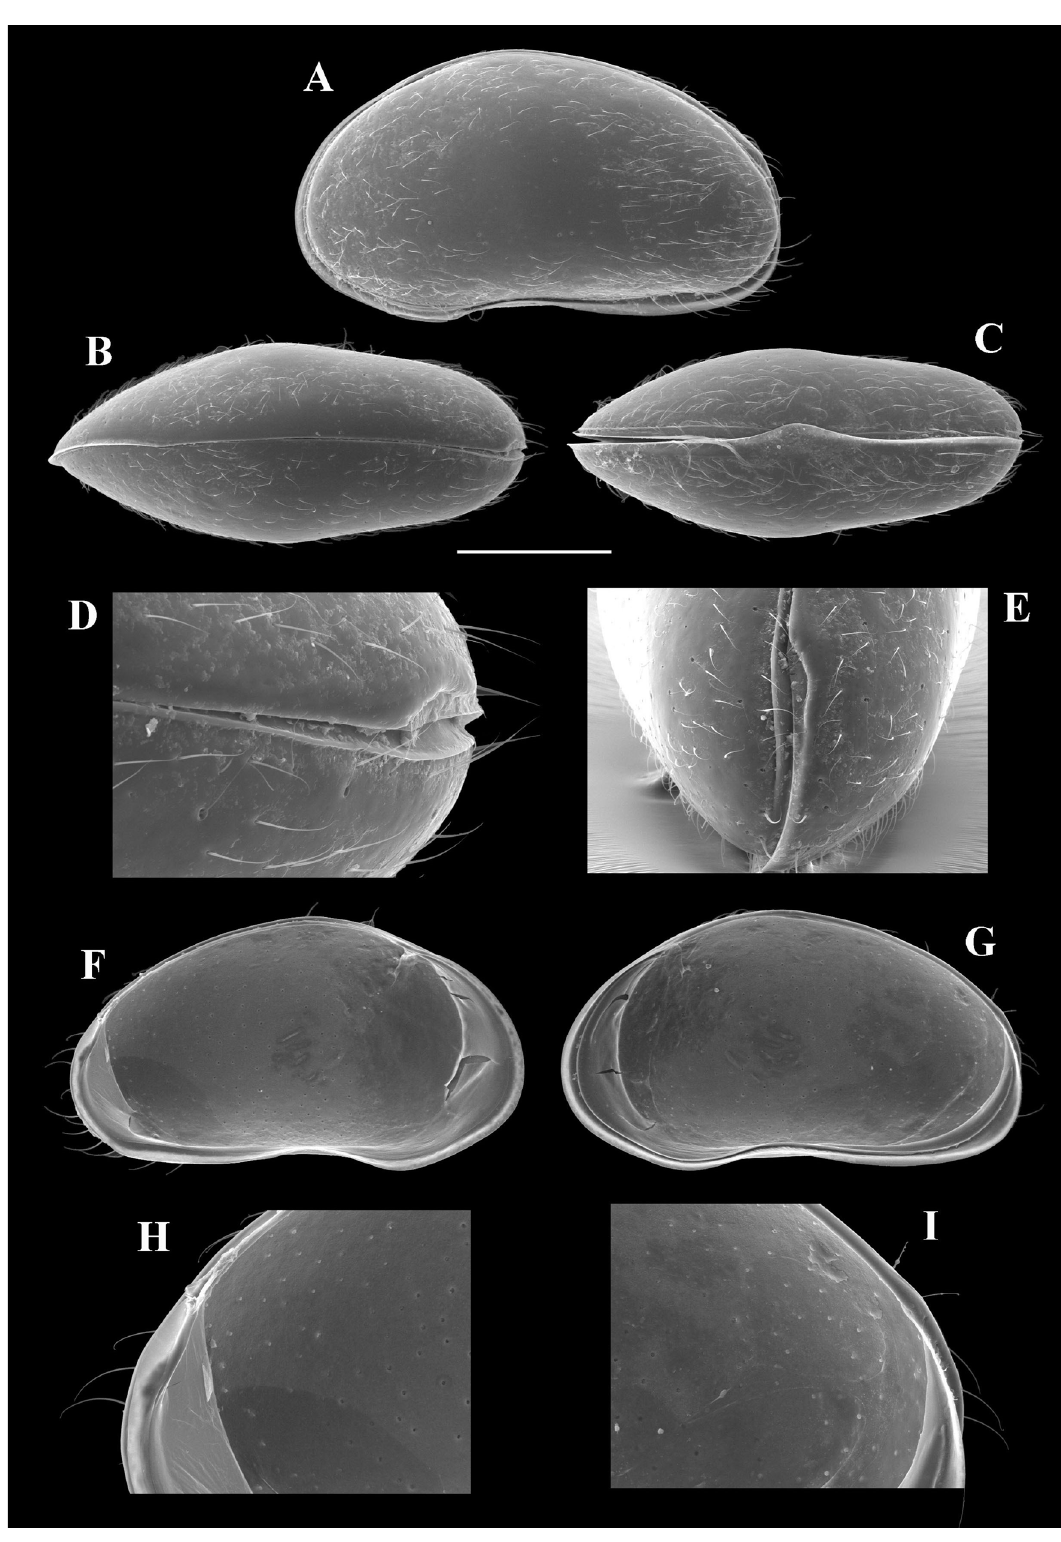
Fig. 5. Siamopsis suttajiti gen. et sp. nov., ♀. A . CpL (MSU-ZOC.198). B . CpD (MSU-ZOC.199). C . CpV (MSU-ZOC.200). D . Posterior end of CpD (MSU-ZOC.199). E . CpC (idem). F . LVi (MSU- ZOC.196). G . RVi (idem). H . Postero-dorsal part of LVi (idem). I . Postero-dorsal part of RVi (idem). Scale bar: A–C, F–G = 200 μm; D = 56 μm; E = 104 μm; H–I = 87